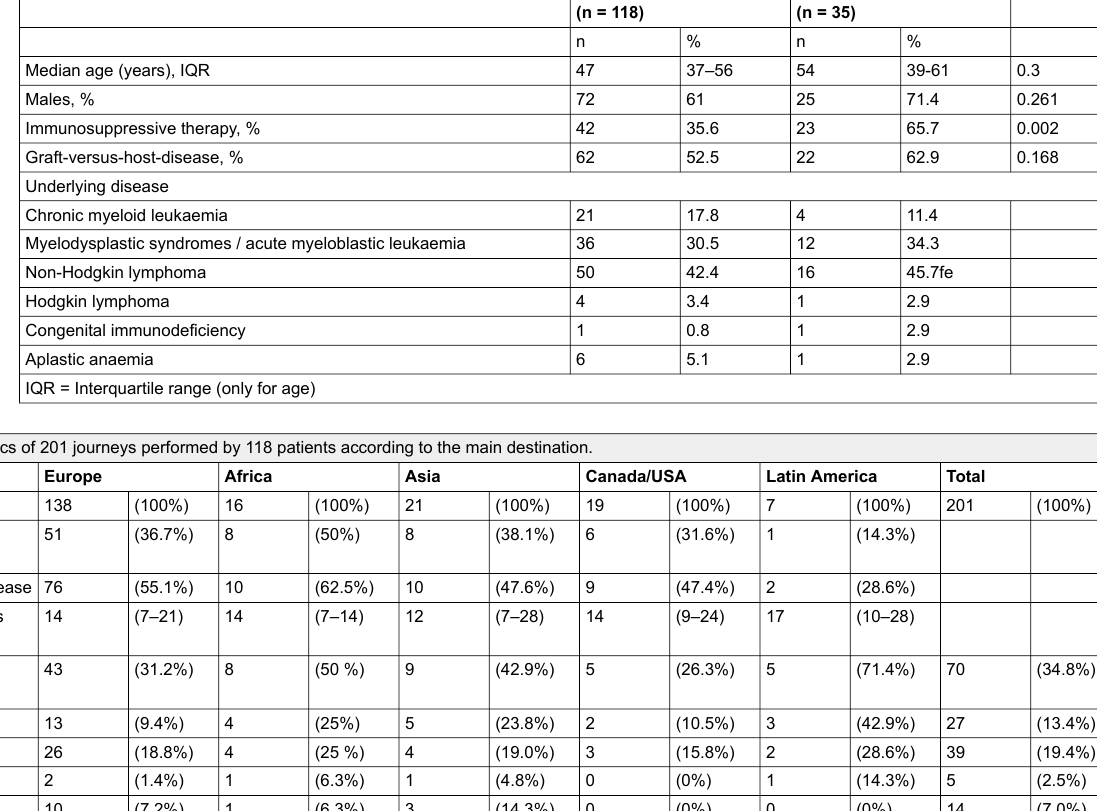
Table 1: General characteristics of the study population (n = 153).